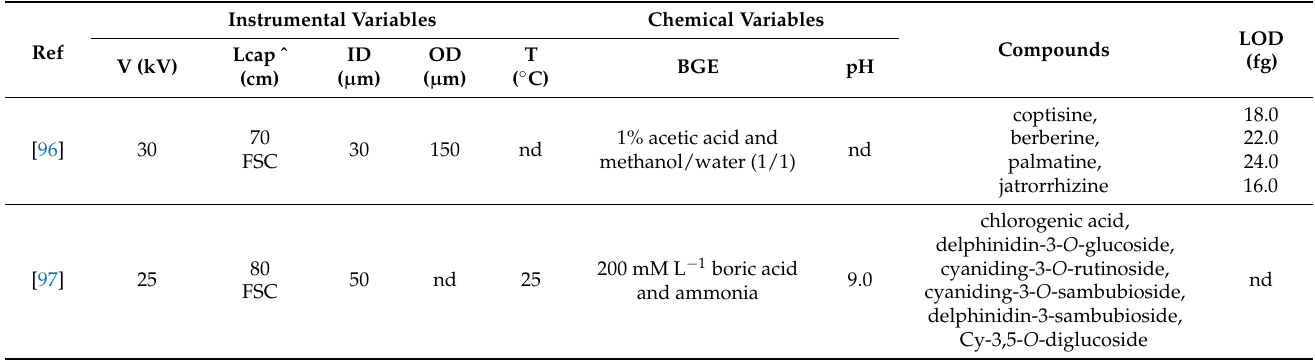
Table 8. Process of separation of analytes with application capillary electrophoresis with MS detection.